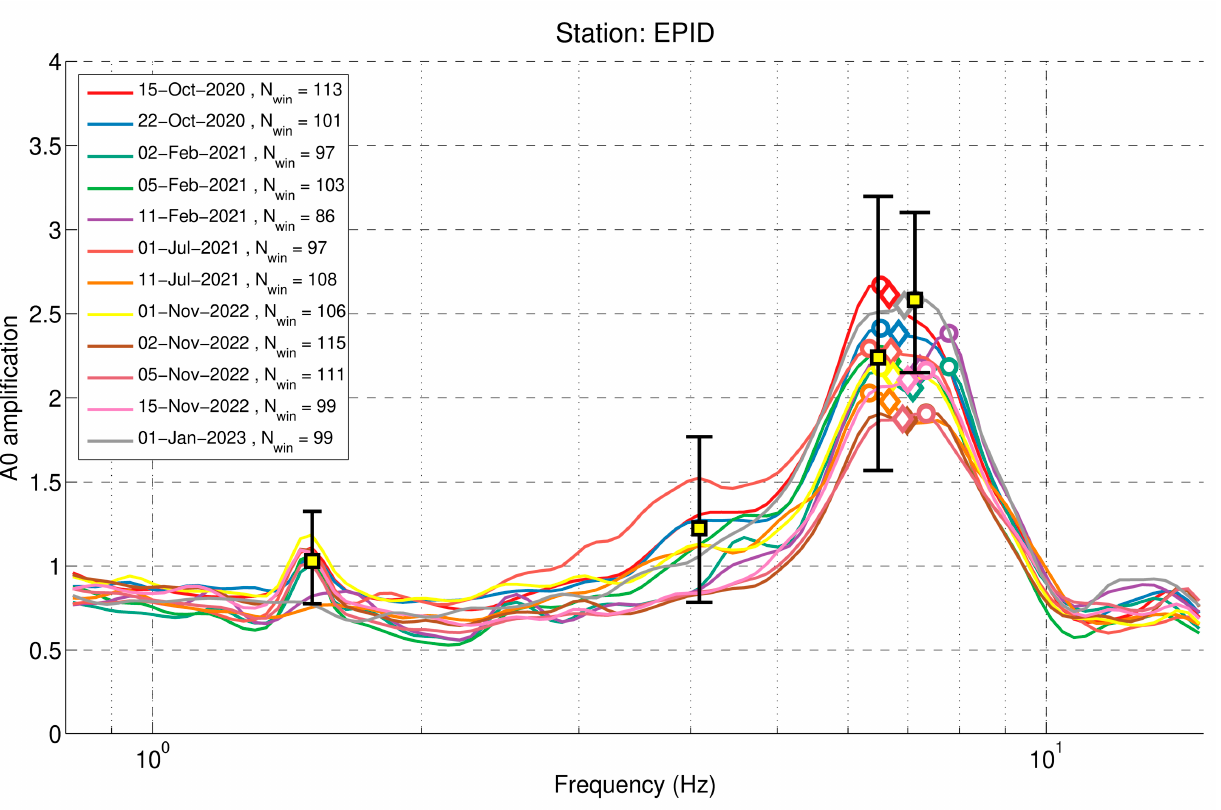
Figure 19. Average HVSR curves (solid lines) determined for station EPID on different days, from 60 s long windows selected after the application of STA/LTA anti-triggering on 6 h long records. Circles denote the global frequency on each curve, while diamond symbols mark the average of the frequency band denoting the range of peak frequencies of the HVSR lines from the individually selected windows (light/dark gray band in Figure 2b). Squares mark the prominent global and secondary peak frequencies recognized from the HVSR spectra, with error bars indicating the uncertainty of the amplification factor (Table